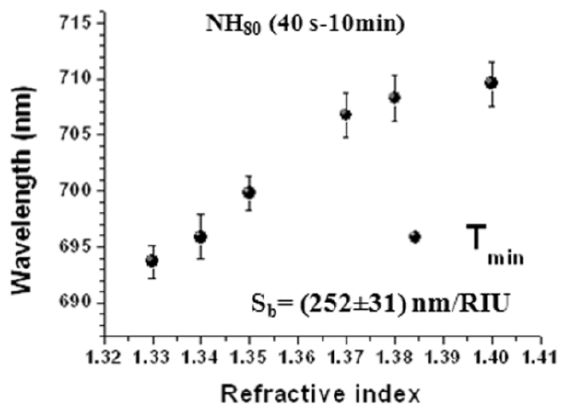
Figure 8. Plots showing the linear dependence on the refractive index of the wavelength position of the transmittance minimum of NH 80 (40 s–10 min). The estimated sensitivity values are also reported.